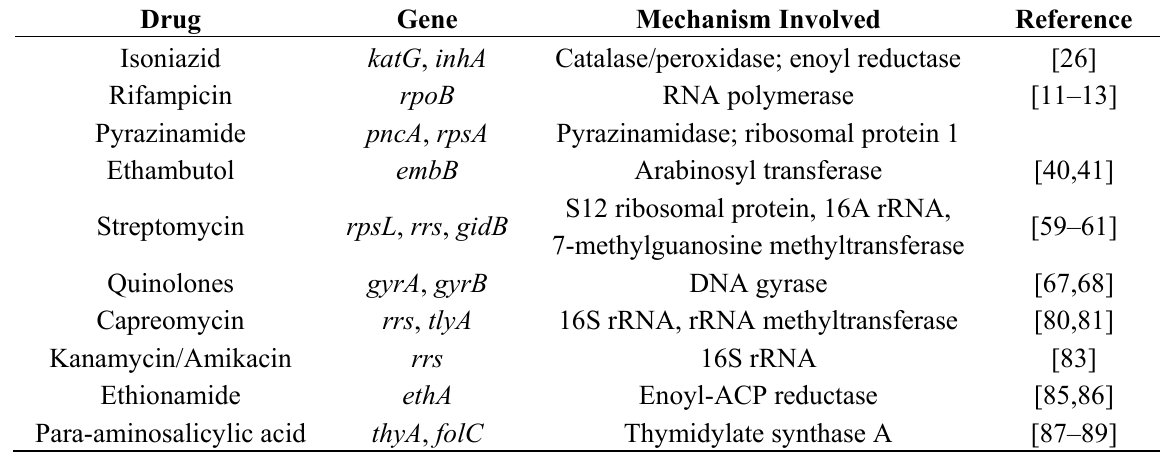
Table 1. First- and second-line TB drugs, genes involved in their activation and mechanisms